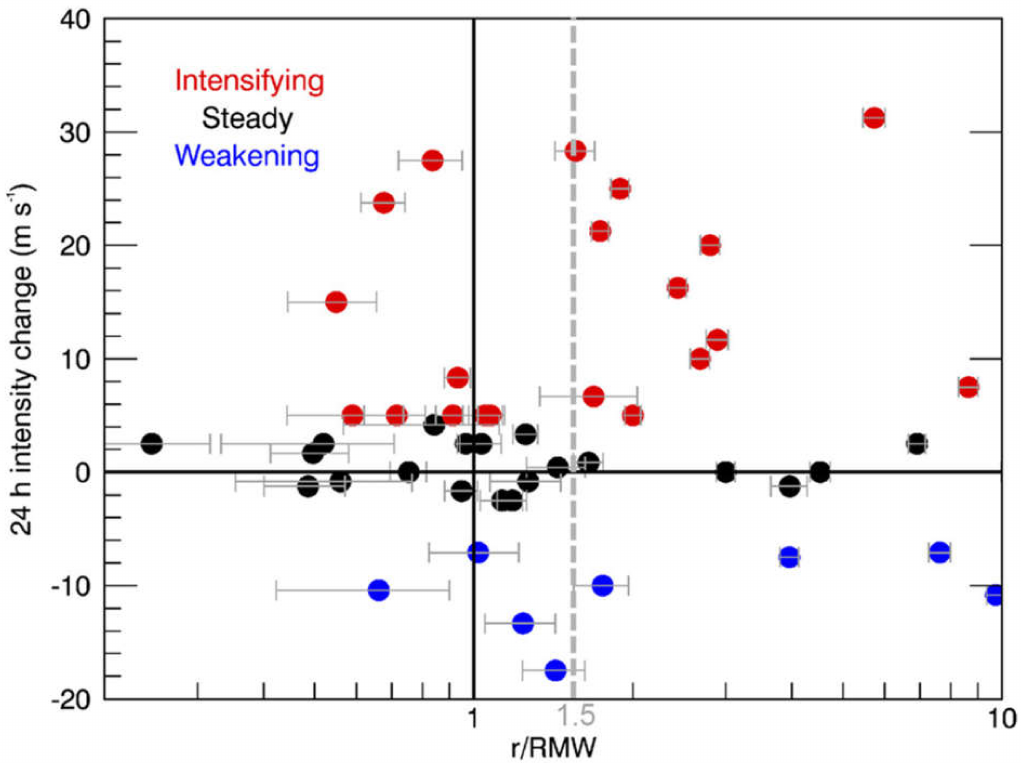
Figure 6. The 24-h intensity change (m s − 1 ) of North Atlantic TCs with an inner-core lightning burst (ICLB) relative to the RMW (r/RMW; logarithmic scale) with aircraft reconnaissance within 1 h of the observed ICLB. The error bars indicate one standard deviation of 10,000 random errors (+0.2 ◦ ) added to the NHC best-track position. Adapted from